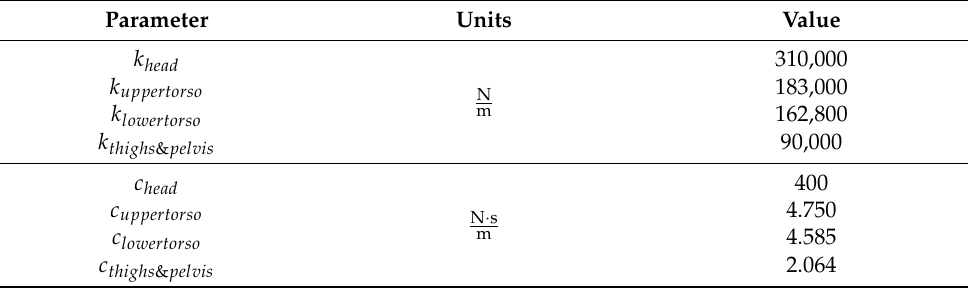
Table 2. Values of the stiffness and damping elements for the human body model.